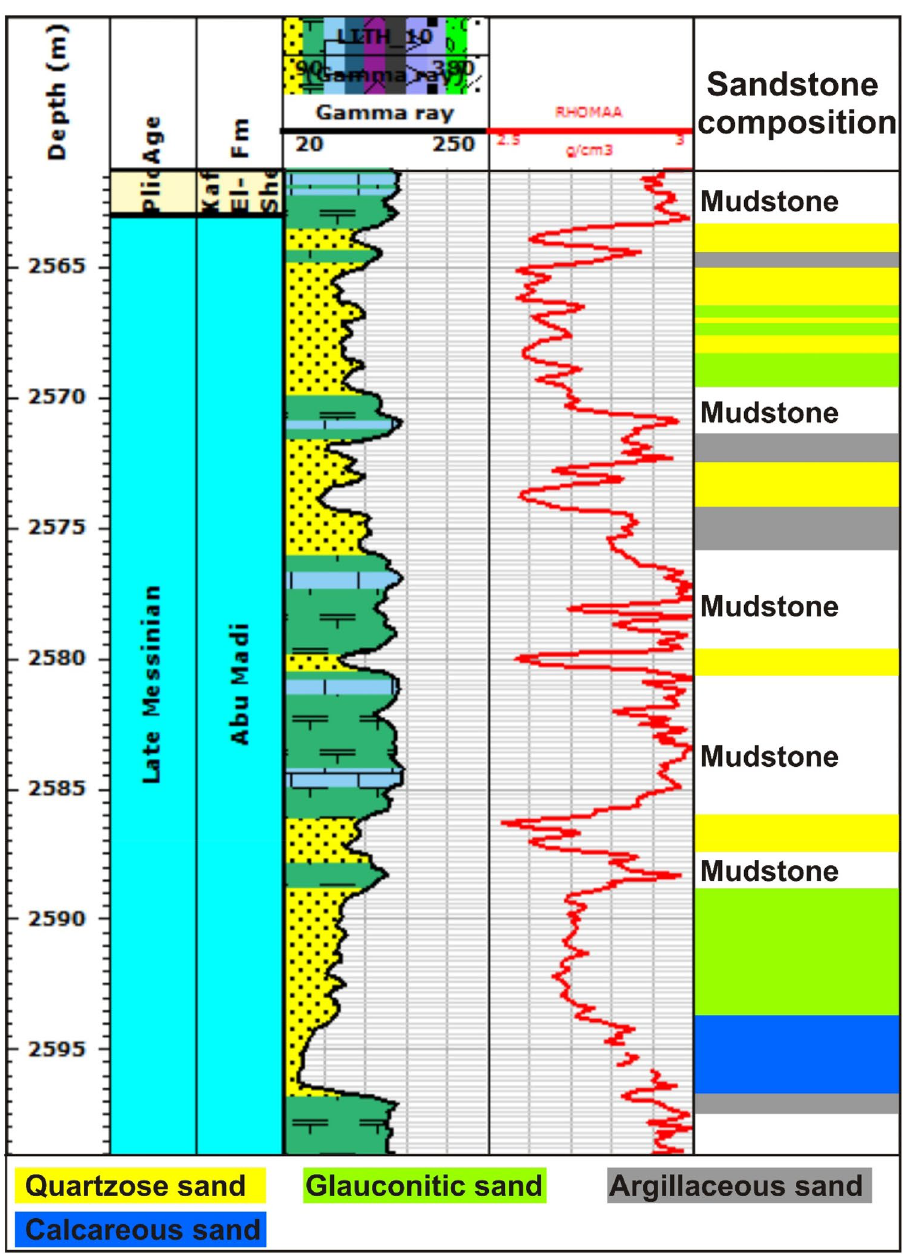
Fig. 10 Composition of the uncored interval of Abu Madi estuarine sandstones and their corresponding wireline log